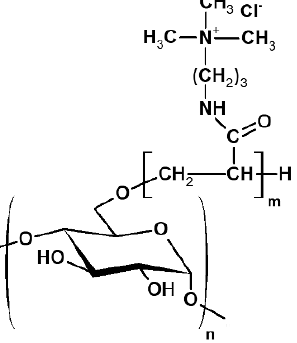
Figure 1. General chemical structure of polycations based on pullulan P- g -pAPTAC. Table 1. Synthesis parameters of pullulan derivatives P- g -pAPTAC [25].